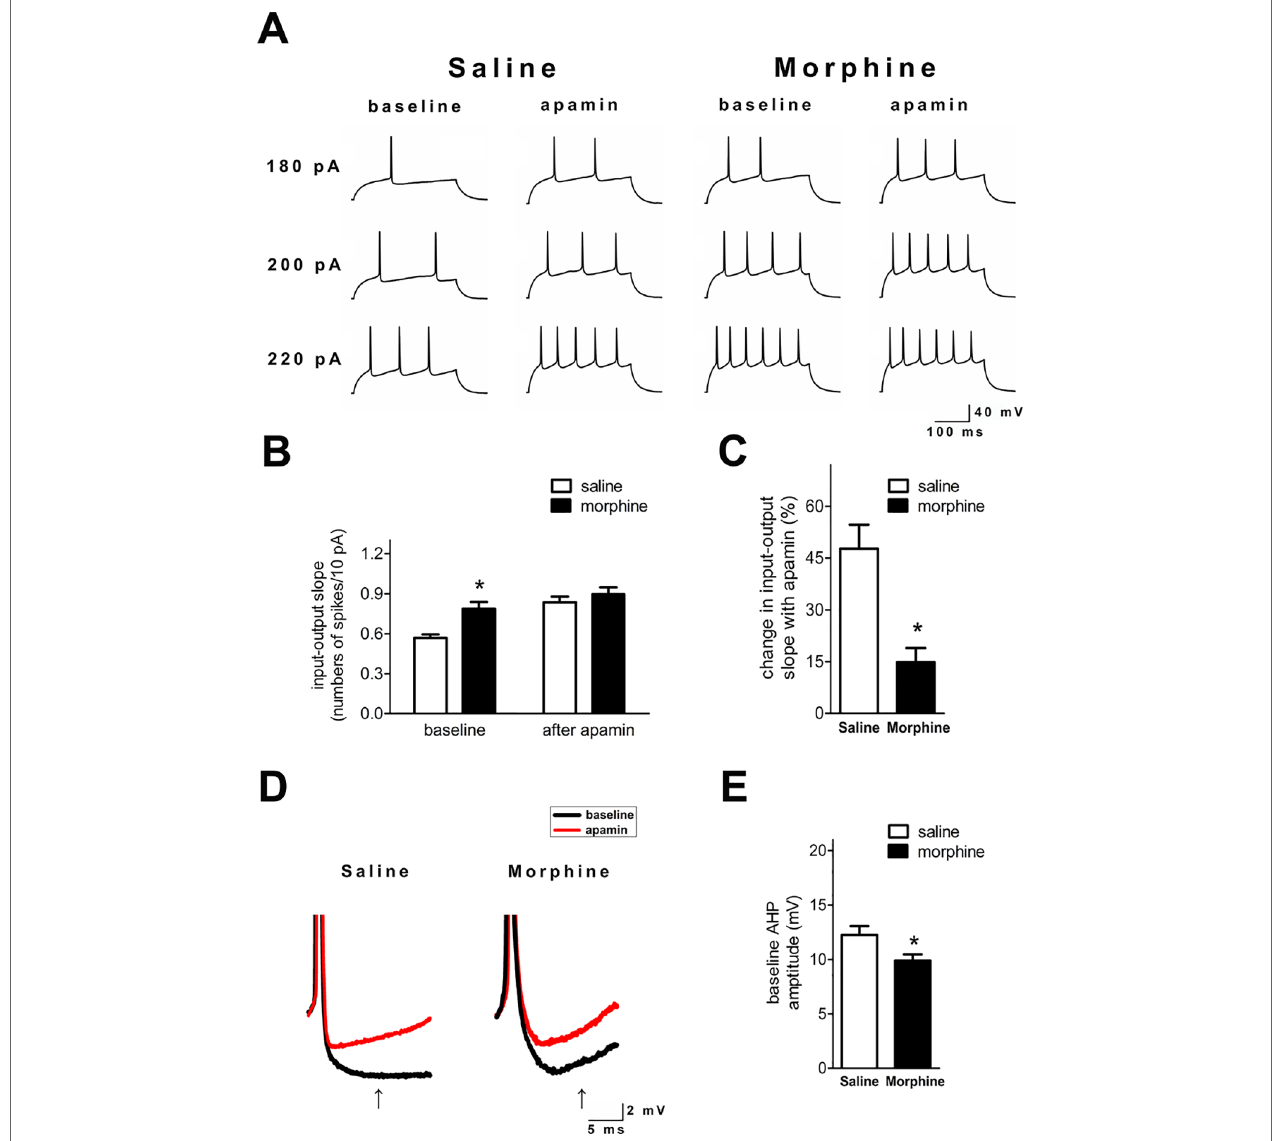
FIGURE 2 | SK inhibition enhanced neuronal firing in the NAc shell after 3 weeks of morphine withdrawal. (A) Examples illustrating that SK inhibition produced a greater enhancement of the firing rate in neurons from the saline mock treatment group versus the morphine withdrawal group. (B) Grouped data showing the changes of input/output slopes after apamin addition in both groups. (C) The relative proportions of apamin-induced changes in the I/O slope were significantly greater in neurons from the saline mock treatment group than those from the morphine withdrawal group. (D) Magnification of the AHP in (A) illustrating the amplitude of the AHP threshold at 15 ms after the AP threshold (arrow). (E) Grouped data showing that the amplitude of the AHP was significantly reduced in neurons from the morphine withdrawal group versus the saline mock treatment group. The data are presented as means ± S.E.M., * p < 0.05 vs.